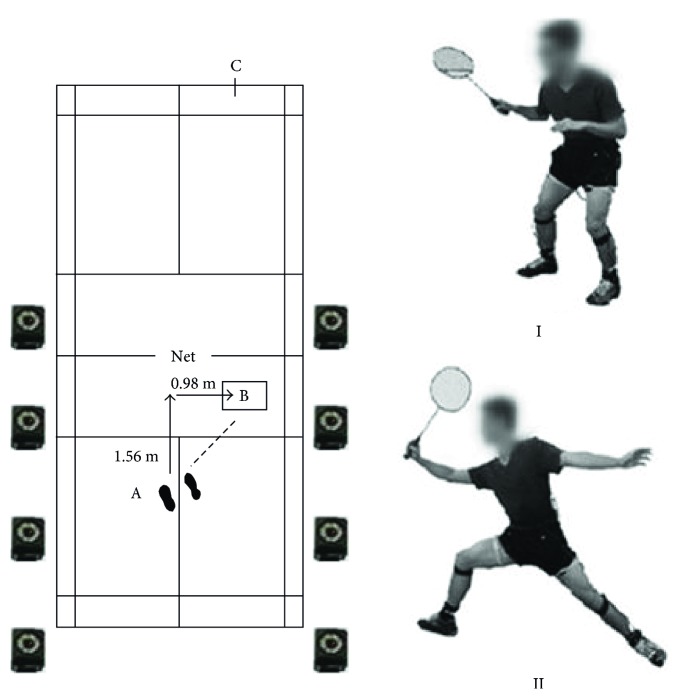
The illustration of simulated badminton court (a) and preparatory (I) and lifting shuttlecock (II) positions (b).